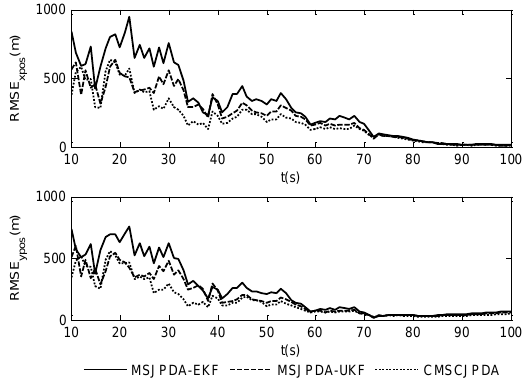
Figure 2. Root mean square position error of target 1.